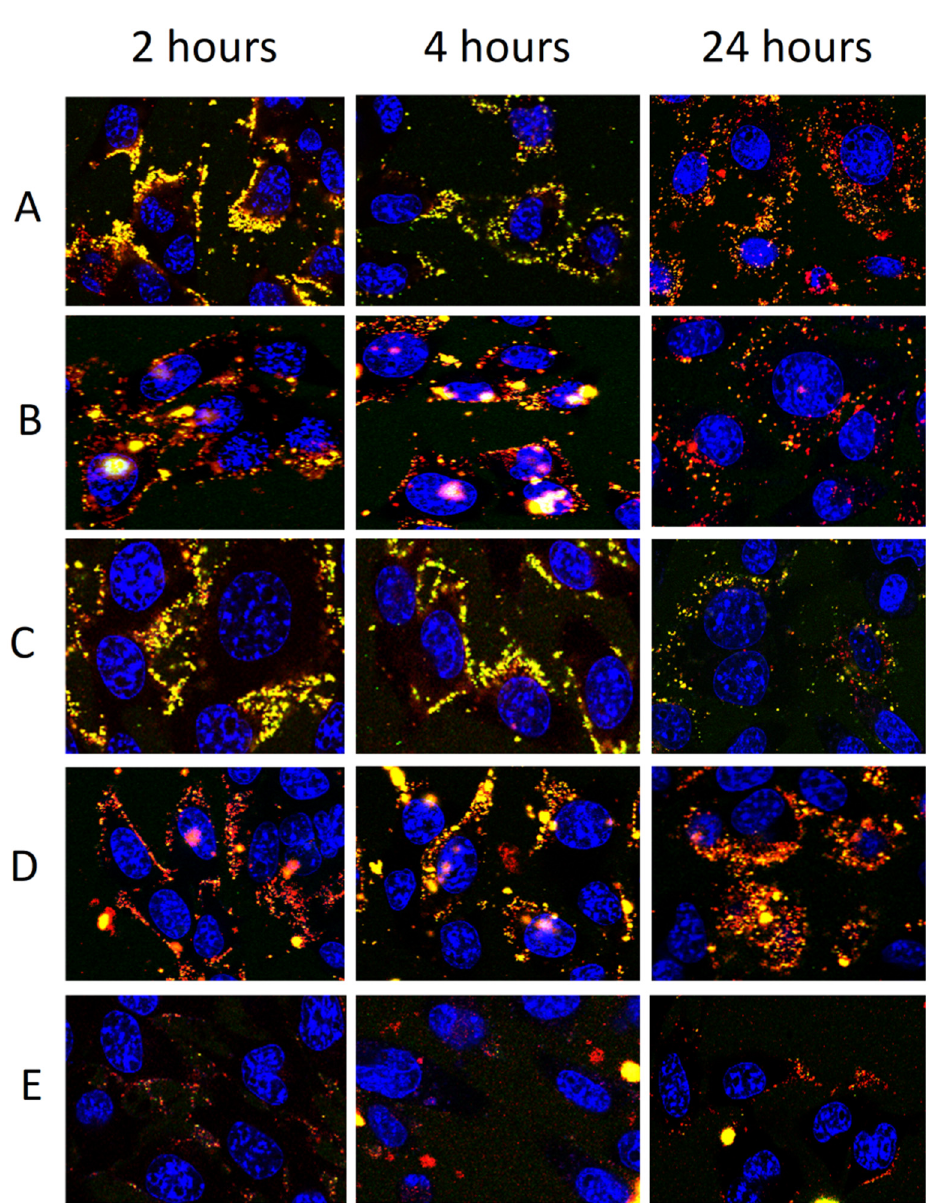
Figure 9. Confocal laser scanning microscopy images of living keratinocytes incubated for 24 h with fluorescently labelled vesicles: liposomes ( A ), glycerosomes ( B ), gluglycerosomes ( C ), gel-gluglycerosomes ( D ), and hyal-gluglycerosomes ( E ). The localization and intensity of the dyes are displayed at 2, 4, and 24 h in red for rhodamine-phosphoethanolamine, green for carboxyfluorescein, and blue for the nucleus. The orange area indicated the superposition of the markers (internalization of intact vesicles). Bars correspond to 50 µ